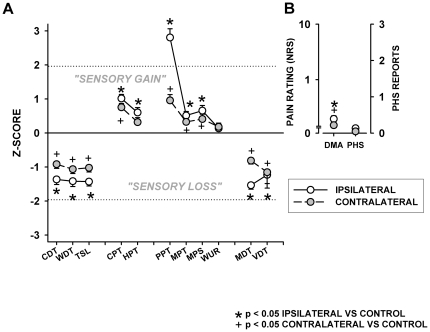
Standardized comparison of QST data normalized to mean and standard deviation of the control group (z-normalisation).A: Somatosensory profile of thermal and mechanical thresholds: Thermal Detection Thresholds: CDT: Cold Detection Threshold; WDT: Warm Detection Threshold; TSL: Thermal Sensory Limen. Thermal Pain Thresholds: CPT: Cold Pain Threshold; HPT: Heat Pain Threshold. Mechanical Pain Thresholds: PPT: Pressure Pain Threshold; MPT: Mechanical Pain Threshold; MPS: Mechanical Pain Sensitivity; WUR: Wind-up ratio. Mechanical Detection Thresholds: MDT: Mechanical Detection Threshold; VDT: Vibration Detection Threshold. B: PHS: Paradoxical Heat Sensation (PHS); Dynamic Mechanical Allodynia (DMA). Significance: ipsilateral hand vs. control: * p<0.05. Significance contralateral hand vs. control: + p<0.05. Patients with chronic CRPS displayed a bilateral hyperalgesia in every painful somatosensory modality as well as bilateral somatosensory loss.